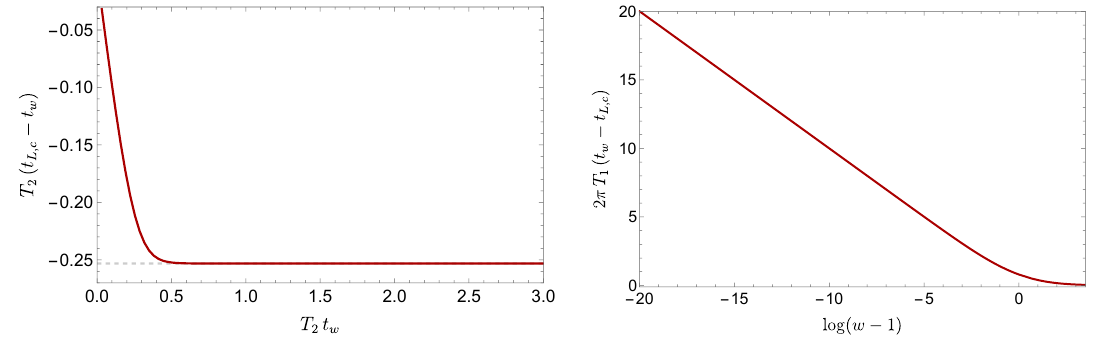
Figure 18. Left: critical time in the symmetric boundary time evolution t extremal surface passing through the bifurcation surface in BH 1 ( P 1 = 0) in shocks of d = 2 BTZ black holes with w = 2 as a function of the time of the shock t w . The dashed gray line indicates the prediction of eq. (4.29) for early shocks. Right: critical time obtained for early shocks with T 2 t w = 6 for various values of w . As indicated by eq. (4.30), the logarithmic dependence on w an indicator of the scrambling time for light shocks. The critical times in these two plots are related to the ending of the plateau in which the rate of computation is proportional to the di(cid:11)erence